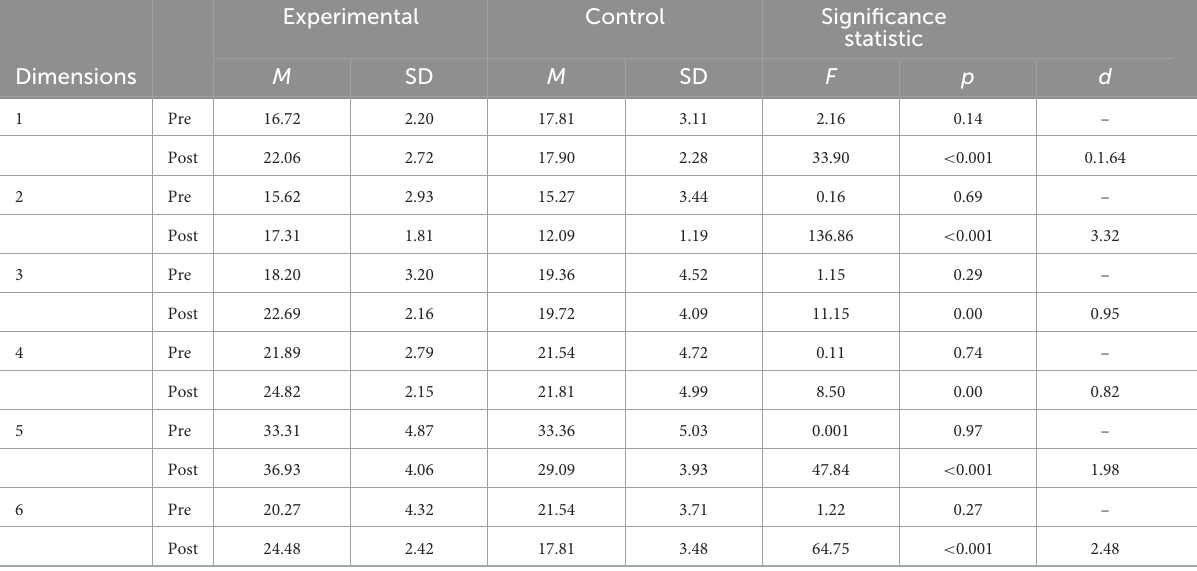
TABLE 3 Means and standard deviations in social skills variables of pre- and post-treatment groups: a posteriori contrasts. Experimental Control Significance